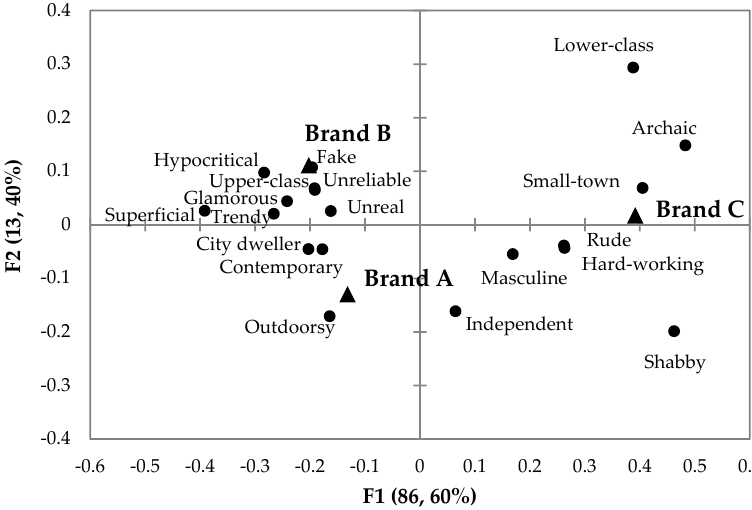
Figure 4. Factorial correspondence analysis of brand personality traits with significant difference according to Cochran’s Q test: Costa Rica.